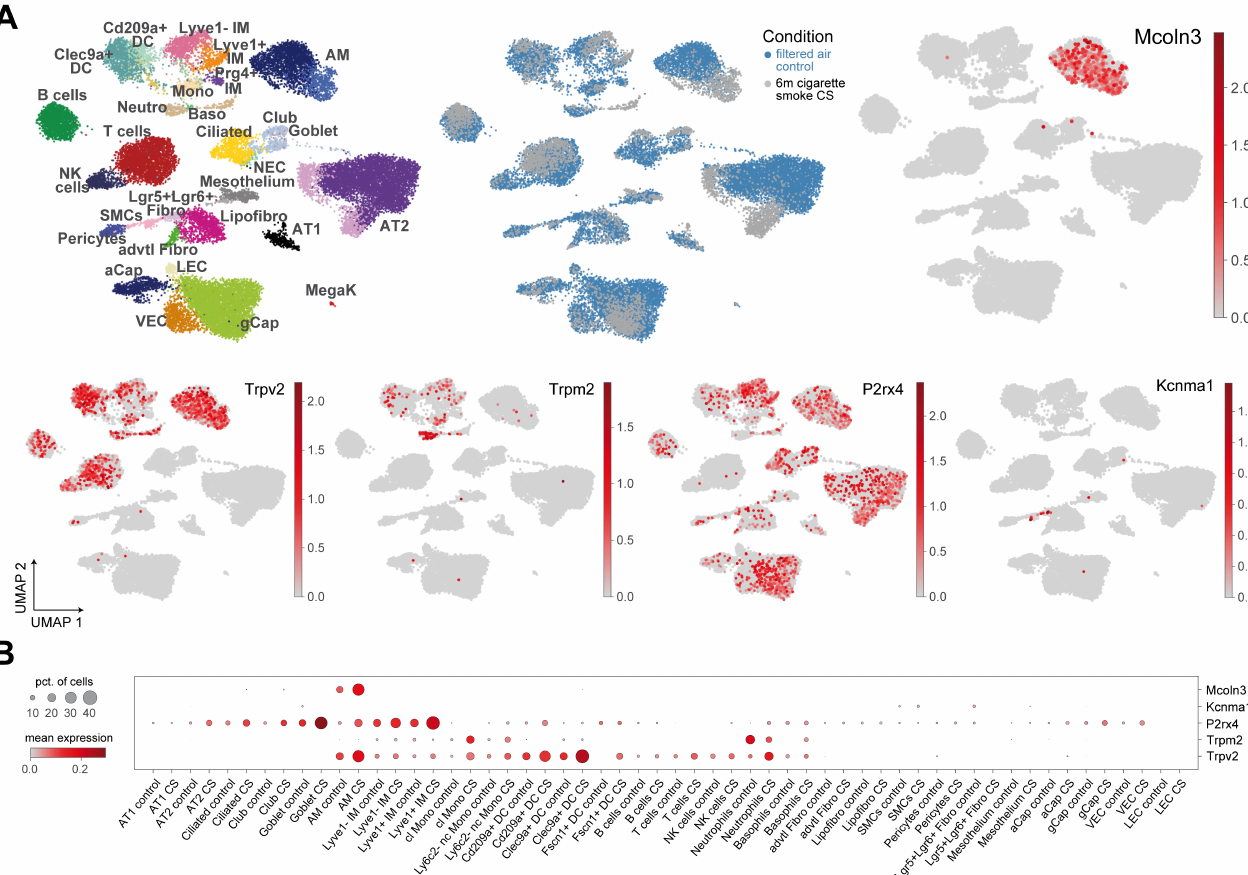
Figure 2. ( A ) Single-cell suspension from murine whole lungs were analyzed using Drop-seq follow- ing 6 months of either filtered air (control) or cigarette smoke exposure (CS). The transcriptomes data are projected using the UMAP algorithm, each cell colour-coded by cell type, exposure condition and expression values of indicated genes. Cell types with prominent expression are highlighted. ( B ) The dotplot reflects normalized expression levels of selected genes across cell types. The dot colour indicates the expression level, and the dot size the percentage of cells expressing the gene per group. DC = dendritic cells; IM = interstitial macrophages; Mono = monocytes; AM = alveolar macrophages; Neutro = neutrophils; Baso = basophils; Ciliated = ciliated cells; Club and Goblet = Club (or clara) and Goblet cells; NK = natural killer cells; NEC = neuroendocrine cells; Fibro = fibroblasts; SMCs = smooth muscle cells; aCap = alveolar capillary; gCap = general capillary; VEC = vascular endothelial cells; LEC = lymphatic endothelial cells; AT1 and AT2 = alveolar epithelial cells type 1 and 2; MegaK =